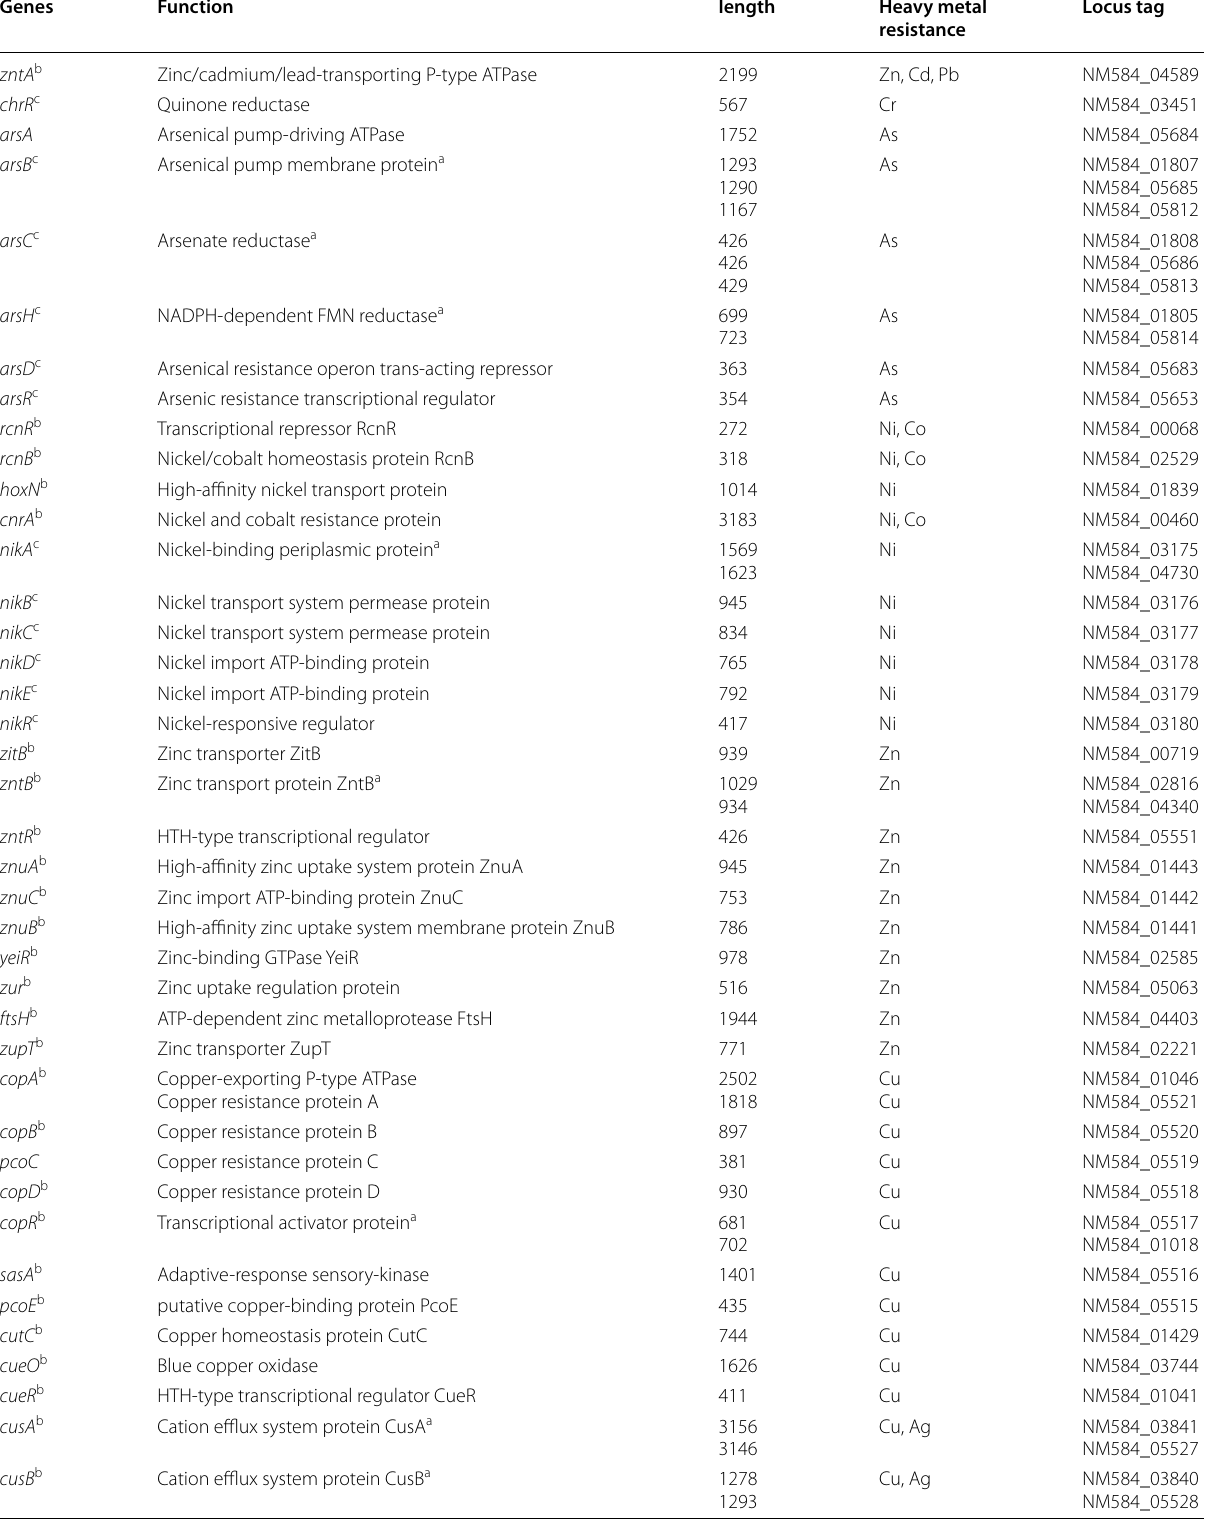
Table 3 Genes/gene clusters of heavy metal resistance in R. planticola FACU 3 Genes Function